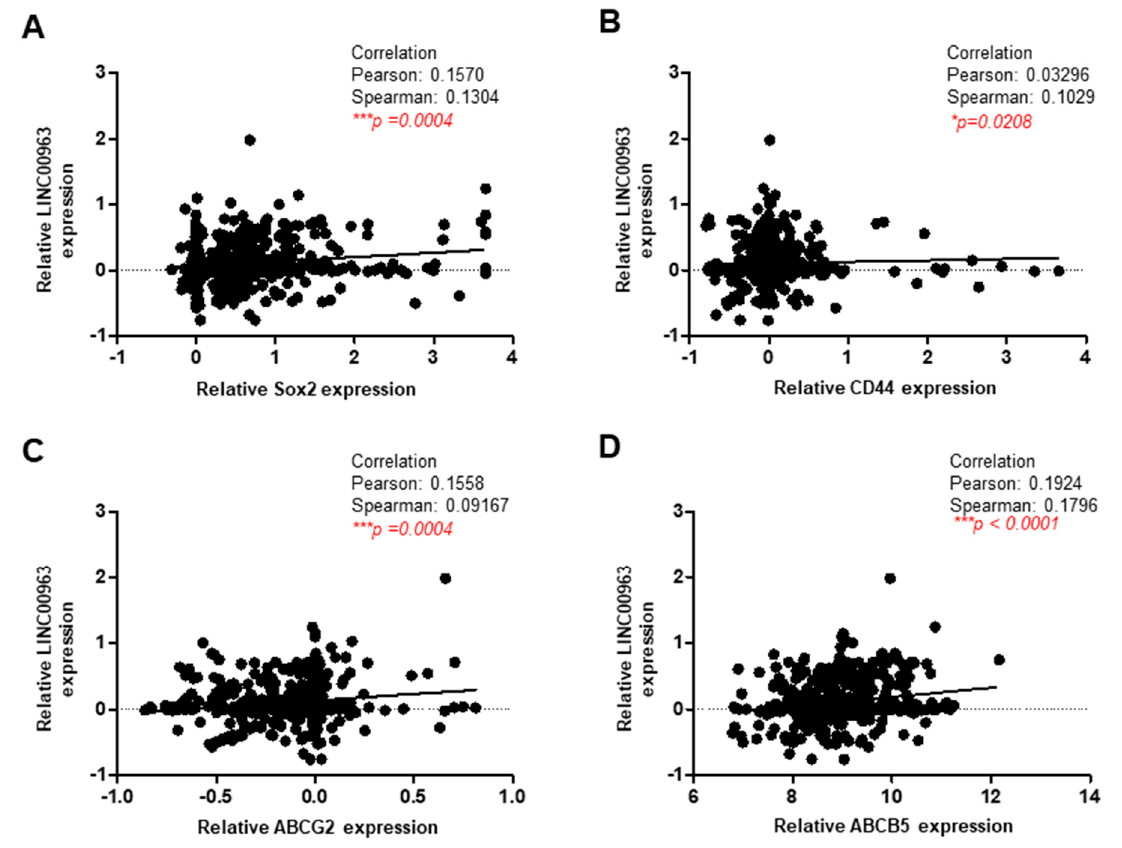
Figure 7. LINC00963 is positively correlated with various stemness and drug resistance markers. The relationship between LINC00963 and several CSC-associated molecules, including stemness markers (Sox2 and CD44) and multidrug resistance markers (ABCG2 and ABCB5), were evaluated through a TCGA dataset using Pearson’s correlation.